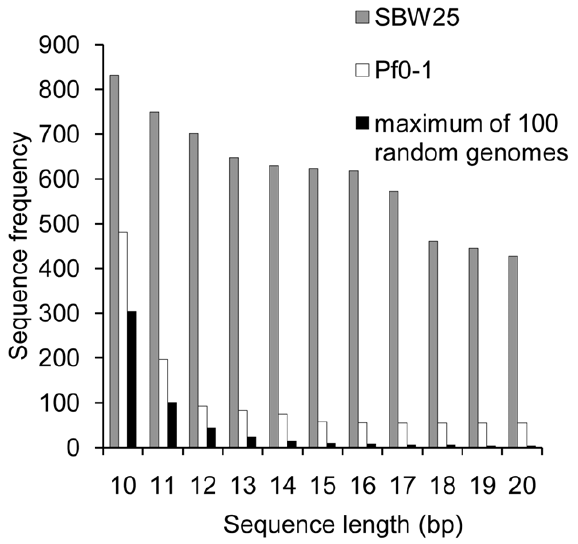
Figure 1. Frequency of common oligonucleotides in the genome of P.fluorescens SBW25. Data shows comparisons to both a random model, and to the closely related P. fluorescens Pf0-1 genome. The random model is based on 100 genomes generated with the same dinucleotide content, replication bias and length as the SBW25 genome. P. fluorescens Pf0-1 shares the same GC-content as SBW25 and has a highly similar dinucleotide content (Table S1); coding density differs by 1.7% and the genome length differs by 4%.